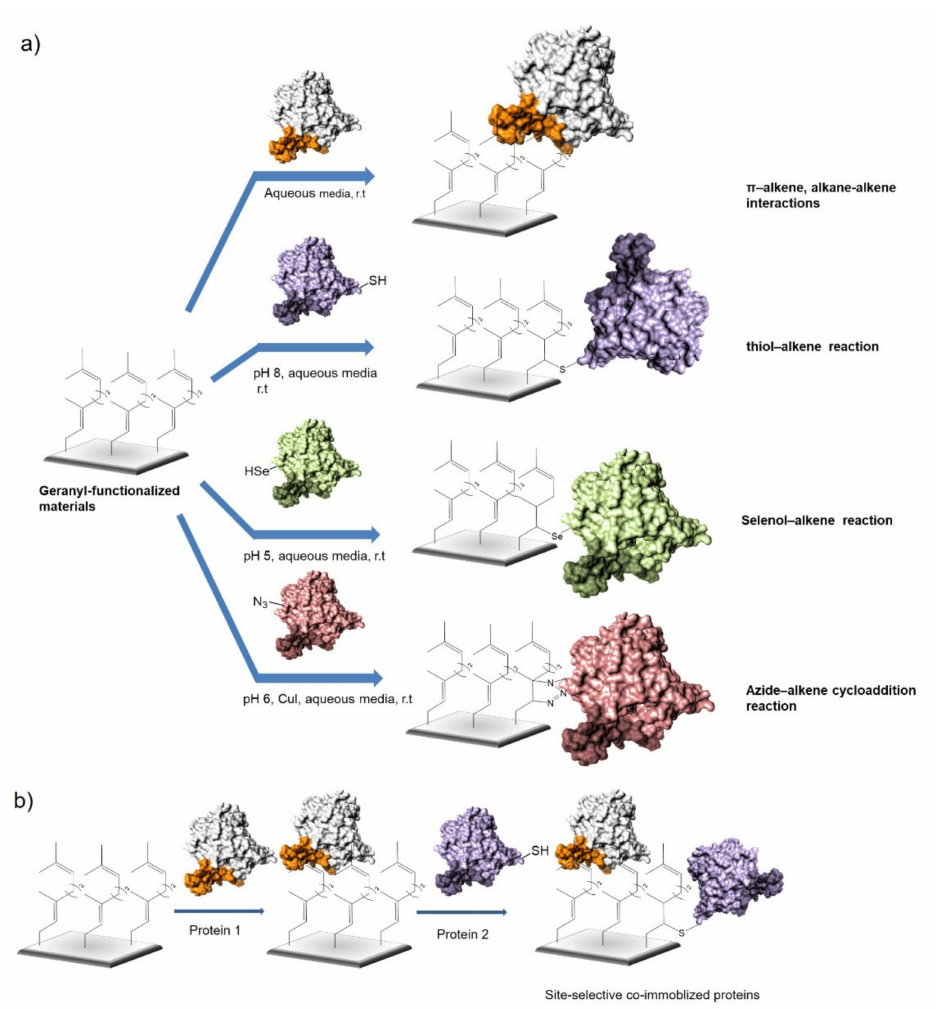
Figure 1. Site-selective immobilization of proteins on geranyl-functionalized materials. ( a ) Po- tential different immobilization strategies on geranyl supports. ( b ) Technology for site-selective co-immobilization of two different proteins under mild